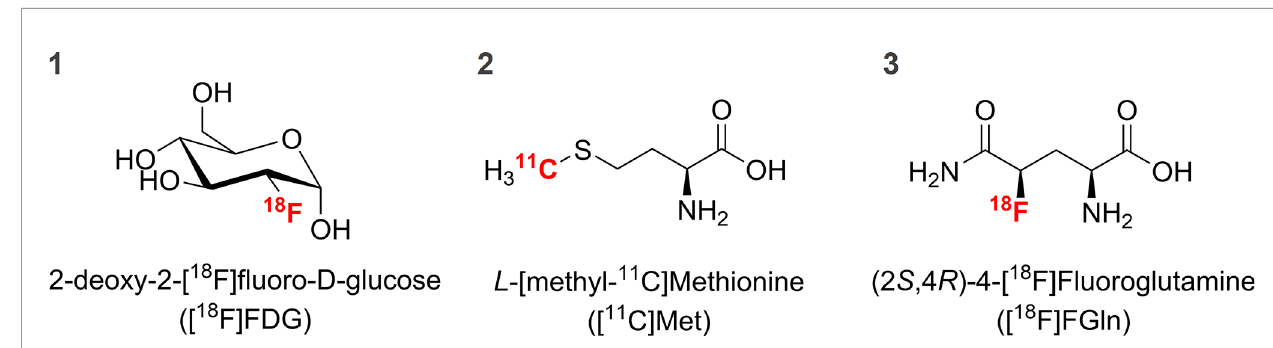
FIGURE 1 | Chemical structure of the PET radiopharmaceuticals used in this